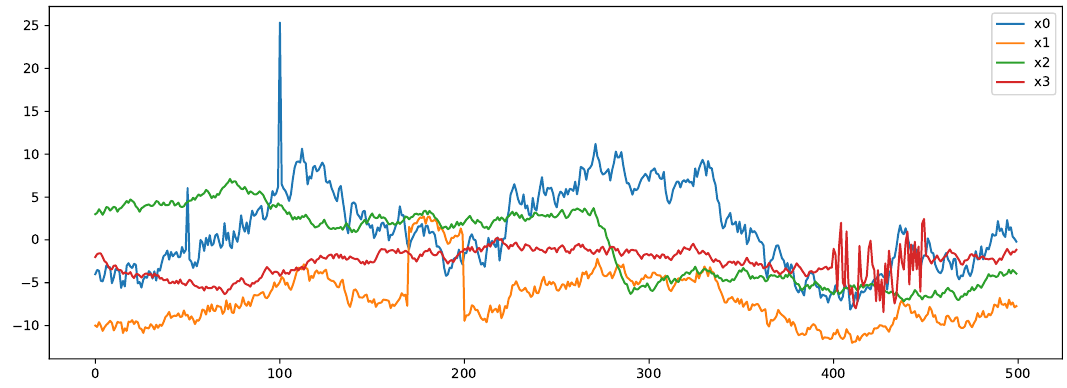
Figure 2. Synthetic anomaly data stream created with Anomaly Generator on Time Series